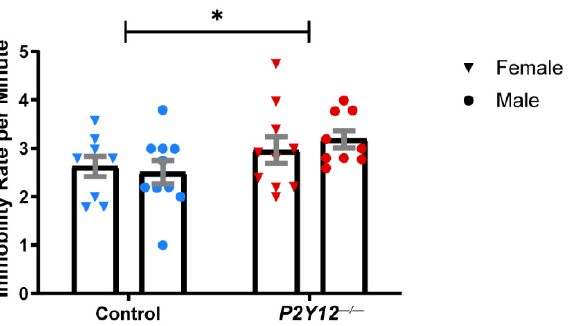
Figure 4. P2Y12 − / − mice exhibit higher anxiety-like behavior. P2Y12 − / − mice had a higher immo- Figure 4. P2Y12 —/— mice exhibit higher anxiety-like behavior. P2Y12 —/— mice had a higher immo- bility rate in the Figure 3. Two-way ANOVA, Sidak post hoc, * p < 0.05; n = 20 mice per genotype bility rate in the Figure 3. Two-way ANOVA, Sidak post hoc, * p < 0.05 n = 20 mice per genotype (10 males, 10 females); graph shows the mean +/ − SEM. (10 males, 10 females); graph shows the mean +/ − SEM.